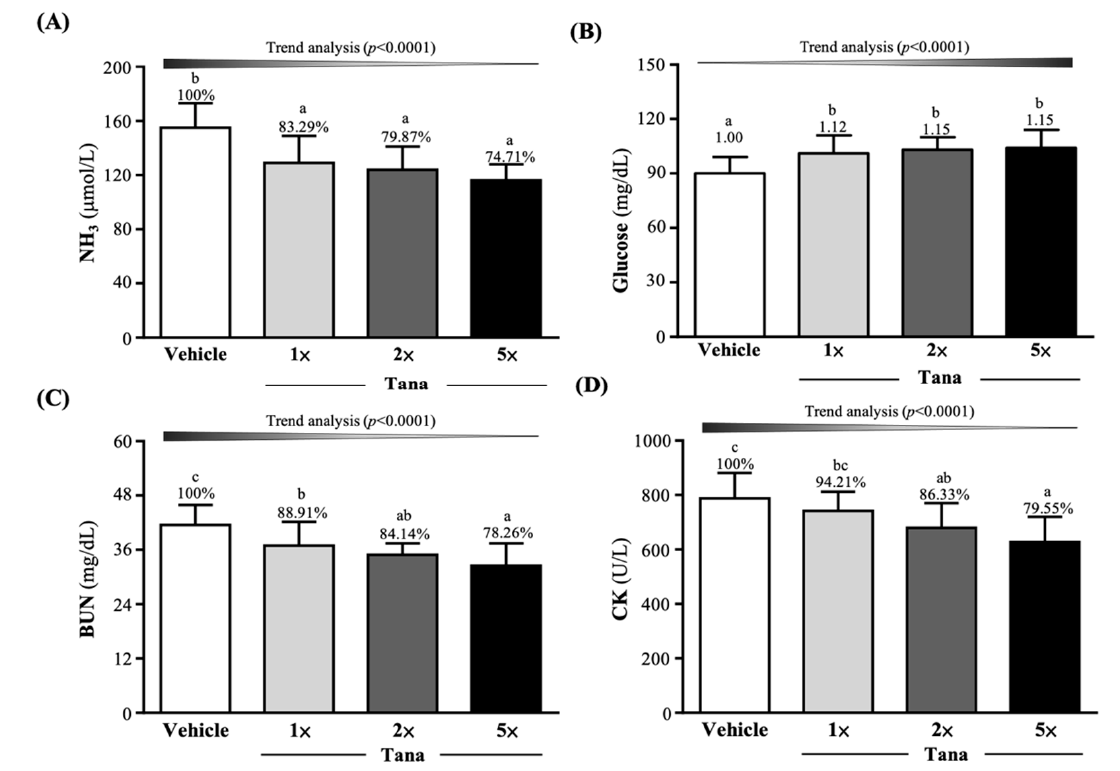
Figure 3. Effect of 4 weeks of Tana supplementation on ( A ) NH3, ( B ) glucose, ( C ) BUN, and ( D ) CK. Data are expressed as mean ± SD for n = 10 mice per group. Different superscript letters (a, b, c) indicate significant difference at p < 0.05.